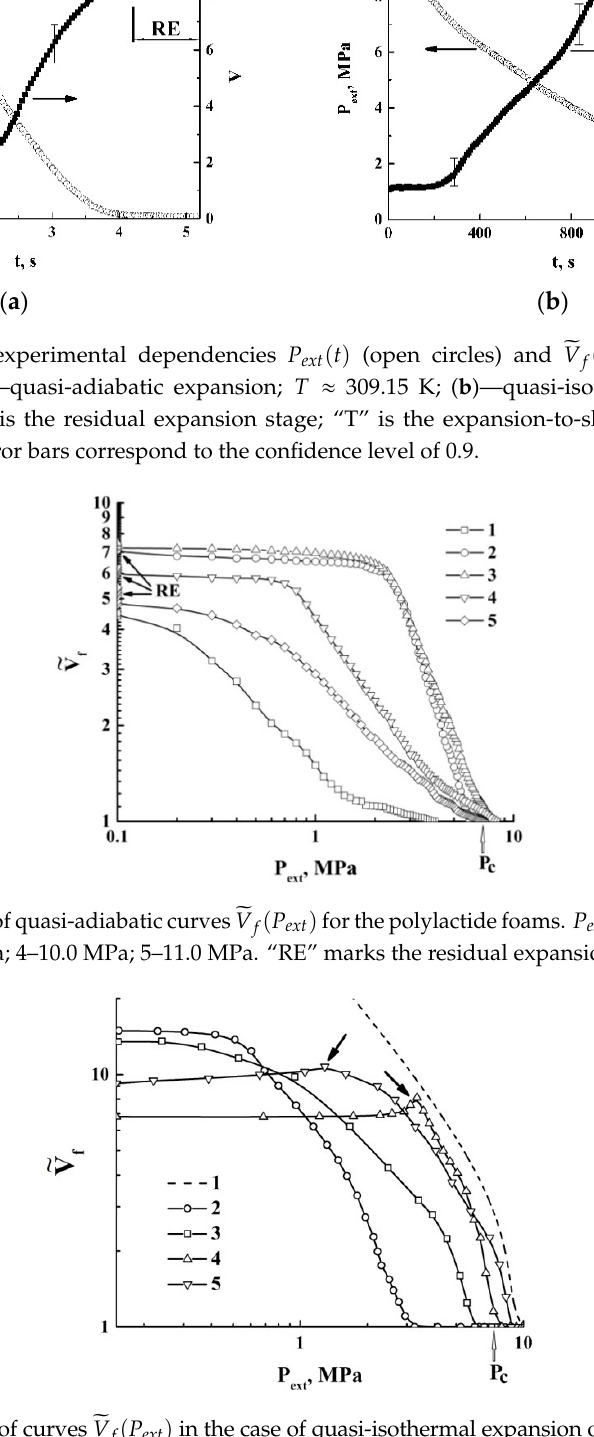
Figure 5. The family of curves (cid:101) V f ( P ext ) in the case of quasi-isothermal expansion of polylactide foams. P ext ( 0 ) = : 2–6.0 MPa; 3–8.0 MPa; 4–10.0 MPa; 5–12.0 MPa. The arrows mark the moments of the expansion-to-shrinkage transition. The dotted line (1) is the theoretical isotherm ( T = 313.15 K) for CO 2 .